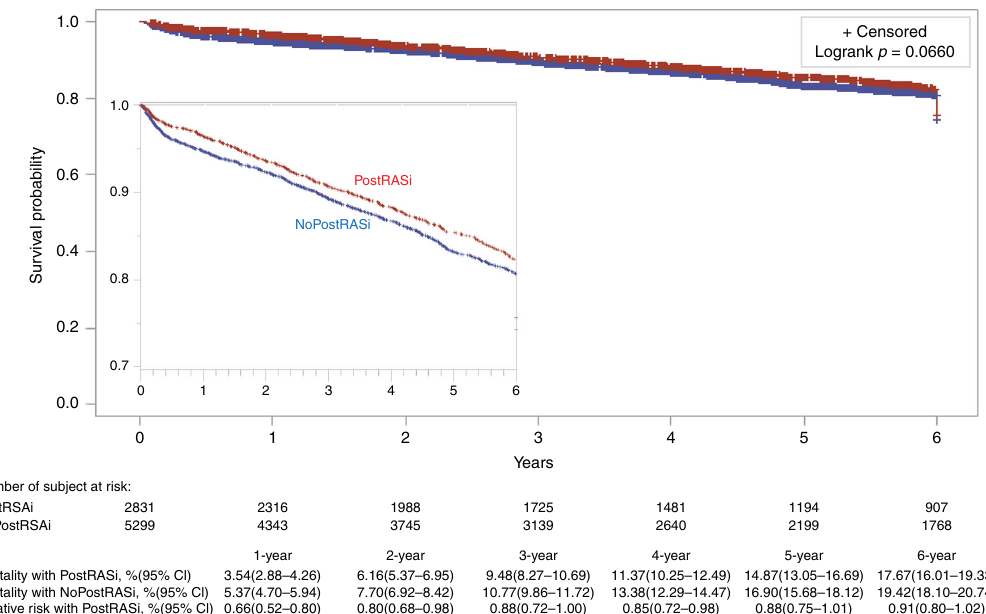
Fig. 5 Rates of survival in patients. Cumulative mortality with and without postoperative RASi (PostRASi) and the relative risk (95% con fi dence intervals in brackets) of PostRASi as compared with no-PostRASi are shown . Logrank p -value is analyzed with using the Kaplan – Meier method (unadjusted). The inset shows the same data on an enlarged y axis